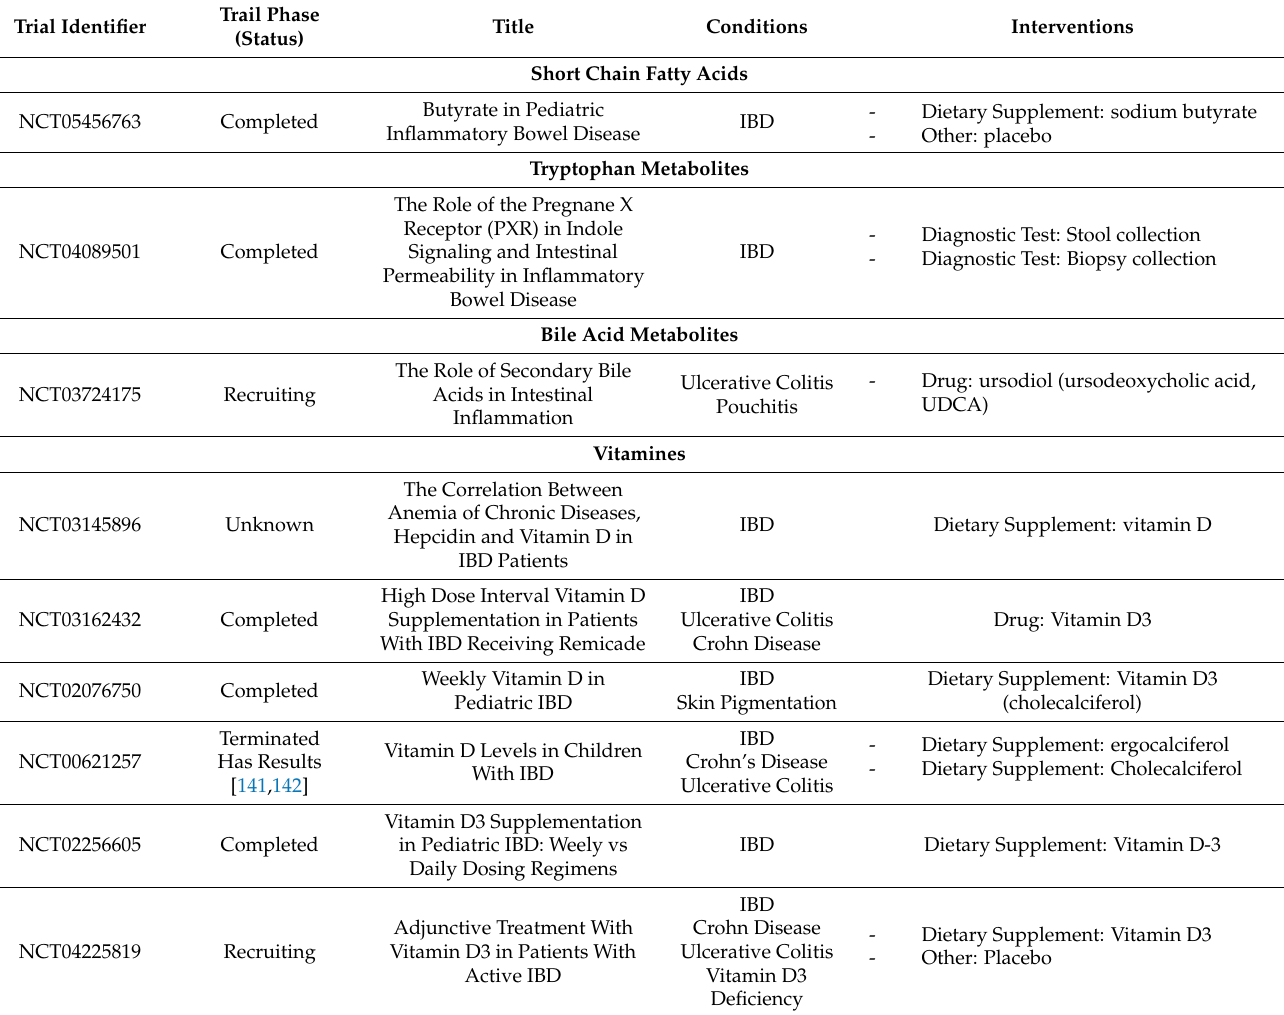
Table 2. Clinical Trials exploiting the use of Microbial Metabolites in